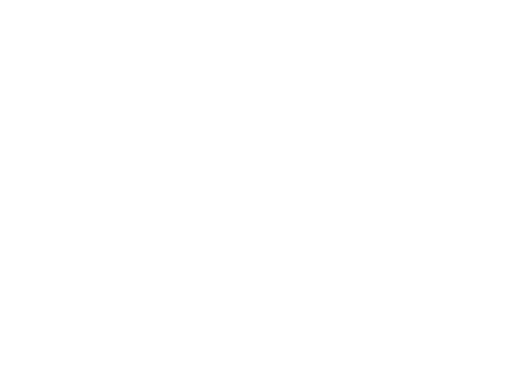
Figure 2. Schematic view of the GSE4290 dataset result after analyzing with GEO2R for the most common genes involved in glioblastoma. It was found that 23 genes are contributed to glioblastoma progression.